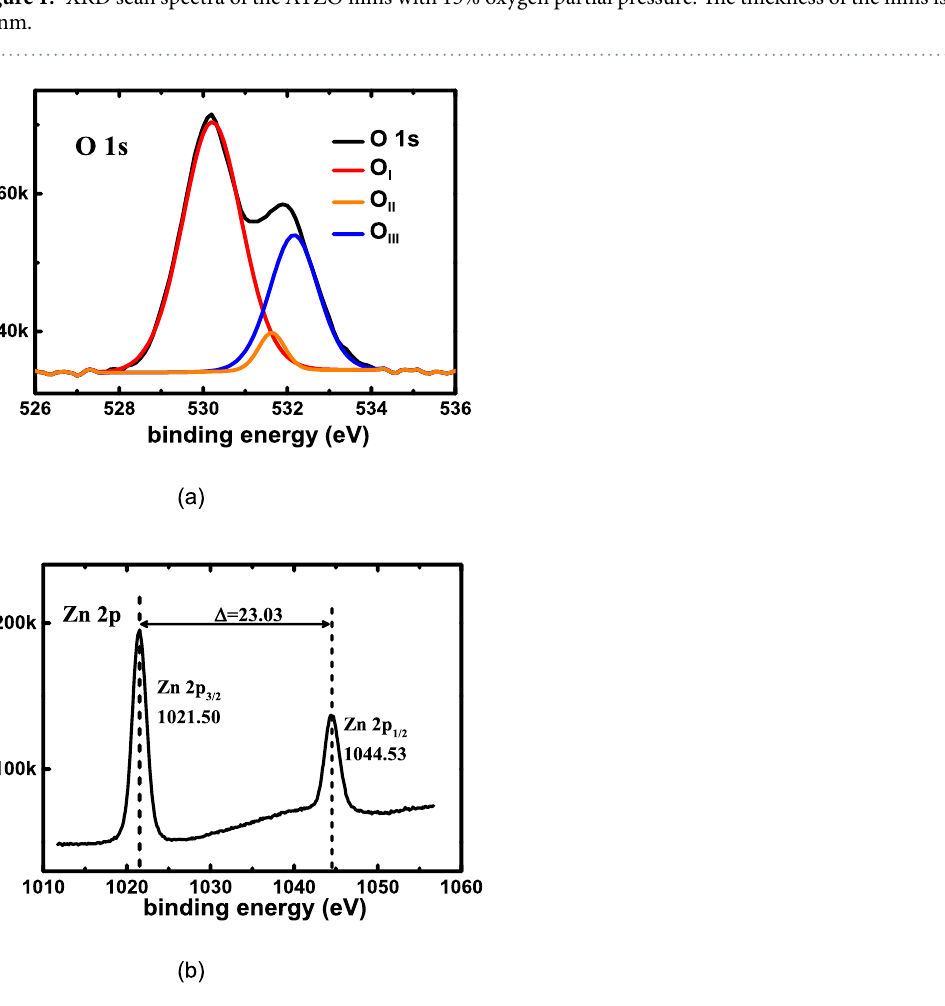
Figure 2. XPS scan spectra of ATZO films. ( a ) O 1 s and ( b ) Zn 2p spectra of the ATZO films with oxygen partial pressure of